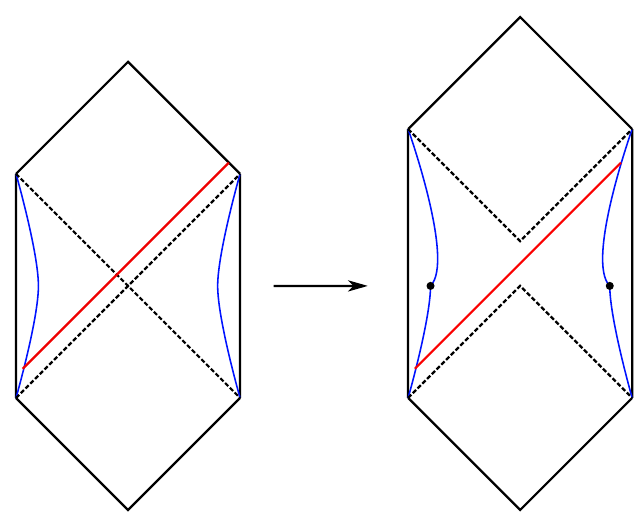
Figure 7 . The traversability picture of [59]: on the left an observer who attempts to cross from the left to the right boundary cannot do so, but once we introduce a perturbation that “kicks” the regulated boundaries inward, they take longer to get back to the AdS observer now can make it